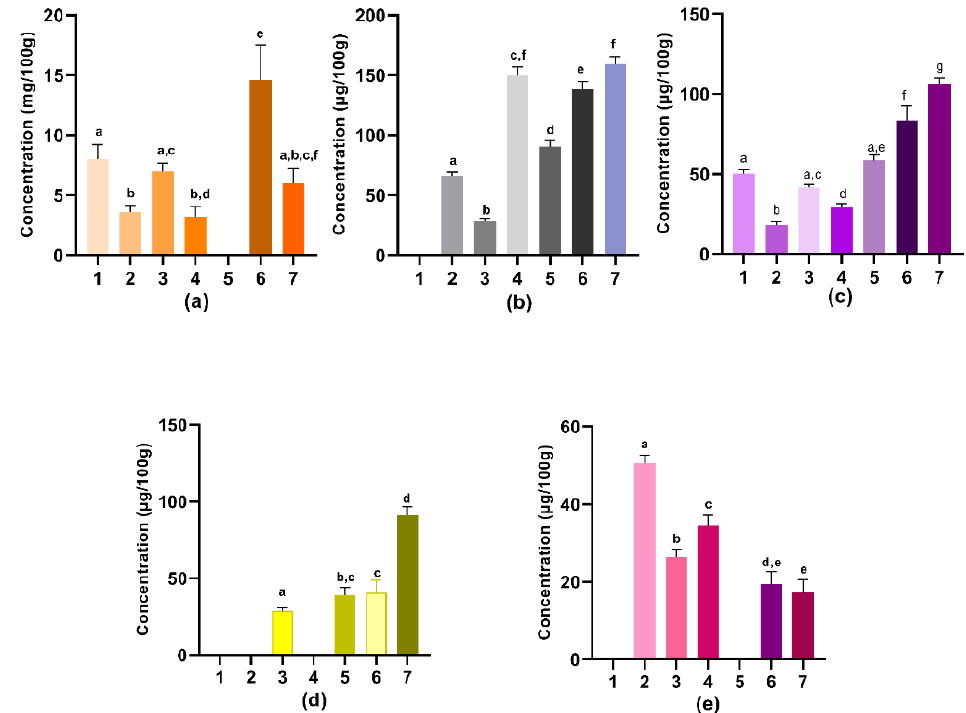
Figure 3. Selected vitamins found in the edible plant organs from Solanum nigrescens ( 1 ), Sechium edule ( 2 ), Rumex obtusifolius ( 3 ), Amaranthus hybridus ( 4 ), Piper auritum ( 5 ), Rhamnus pompana ( 6 ), and Yucca aloifolia ( 7 ). The content of vitamin C ( a ), thiamine ( b ), riboflavin ( c ), vitamin B 6 ( d ), and folic acid ( e ) is shown. Different letters indicate means ( n = 10) with statistically significant differences